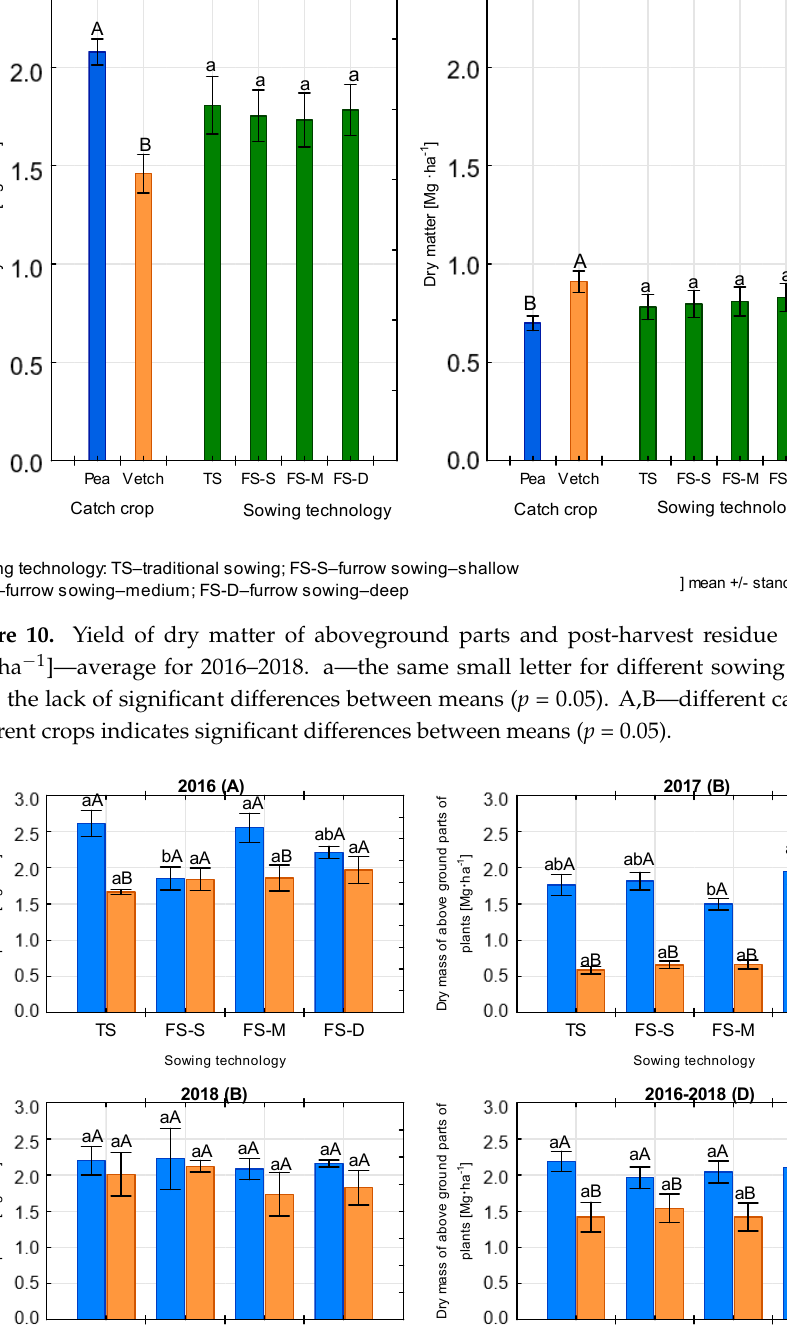
Figure 11. Interaction between factors in shaping the dry matter yield of catch crops [Mg ha − 1 ]. a,b— homogenic groups HSD ( p = 0.05) interaction for sowing method/species (the differences between the four methods of sowing separately for pea and for vetch). A,B—homogenic groups HSD ( p = 0.05) interaction for species/sowing method (differences between pea and vetch for each sowing method).